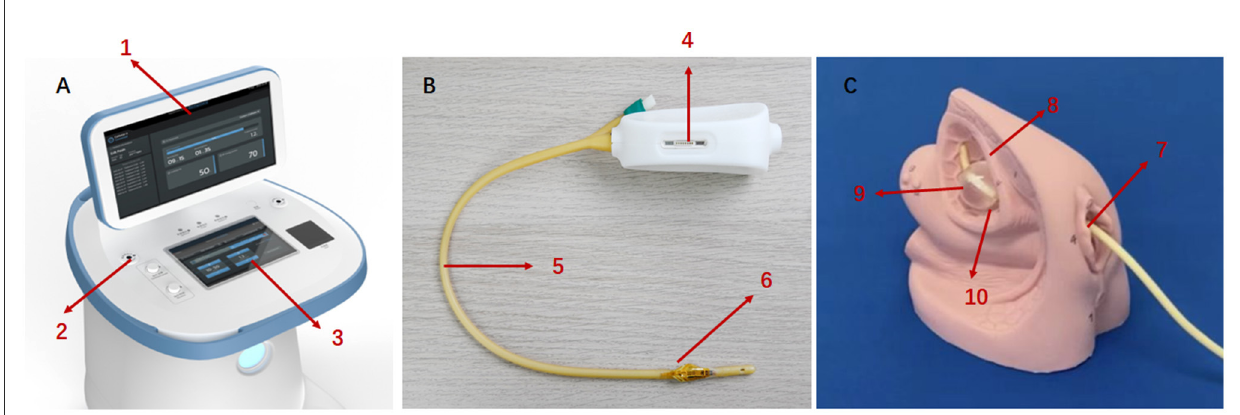
FIGURE1 The key components of micro-RF therapy product and working scheme. (A) Therapeutic apparatus. 1: Display. 2: RF output connect. 3: Keyboard. (B) The single-use modified catheter. 4: Port of RF input. 5: Catheter. 6: Therapeutic electrodes (C) working scheme: through therapeutic electrodes integrated with the surface of the urinary catheter, micro-radiofrequency energy is delivered to the nerve fibers under the bladder wall, blunting part of the nerve endings temporarily. 7: Urethral orifice. 8: Bladder. 9: Catheter balloon. 10: Therapeutic electrodes.